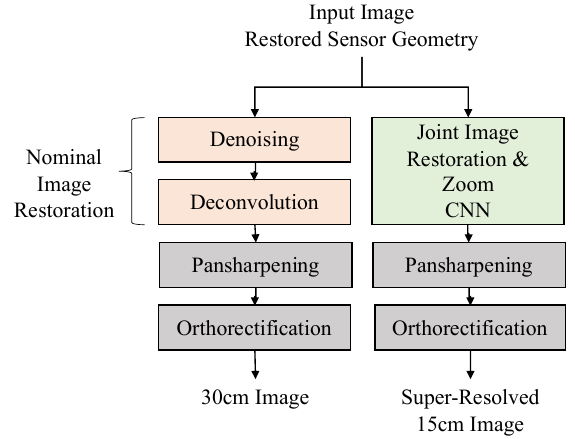
Figure 4 Left: Standard Image Processing Chain. Right: Proposed processing chain integration the joint image restoration and super- resolution